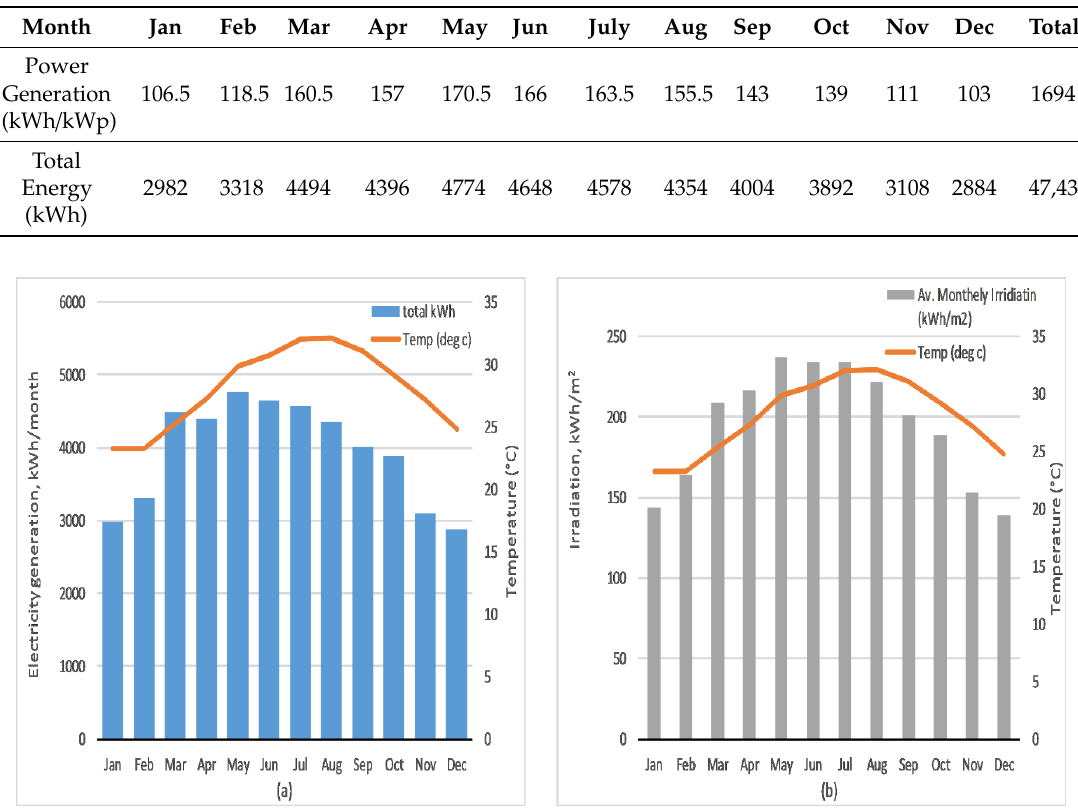
Figure 23. ( a ) Monthly generated power from solar PV panels and ( b ) monthly solar irradiation vs Temperature.